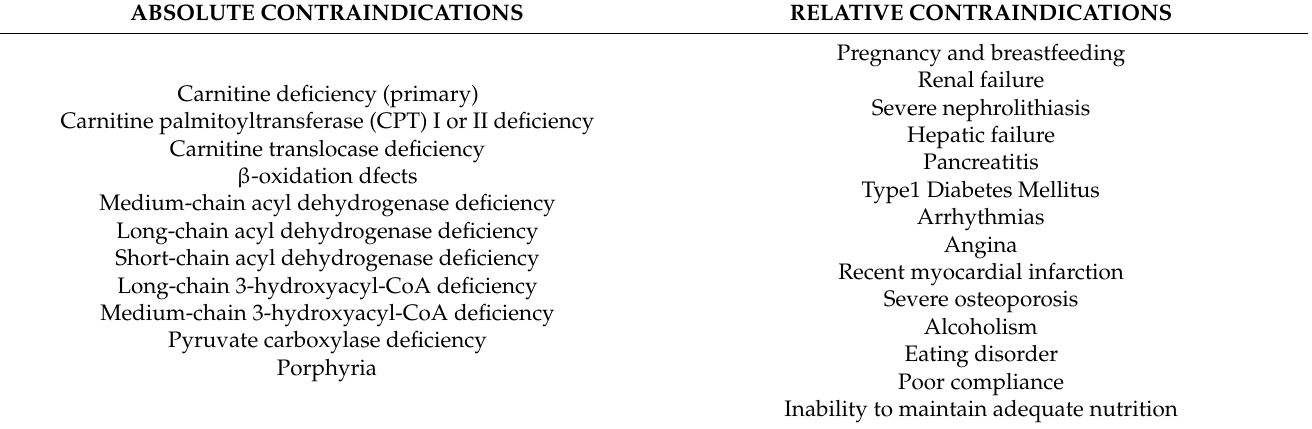
Table 2. Absolute and relative contraindications to ketogenic diet.